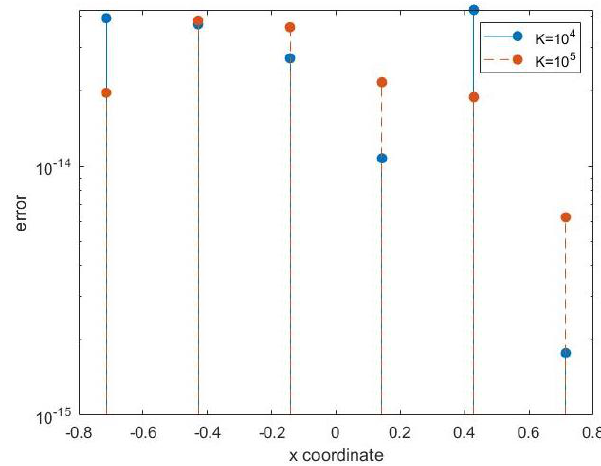
Figure 3. The absolute error for N = 5, m = 5.